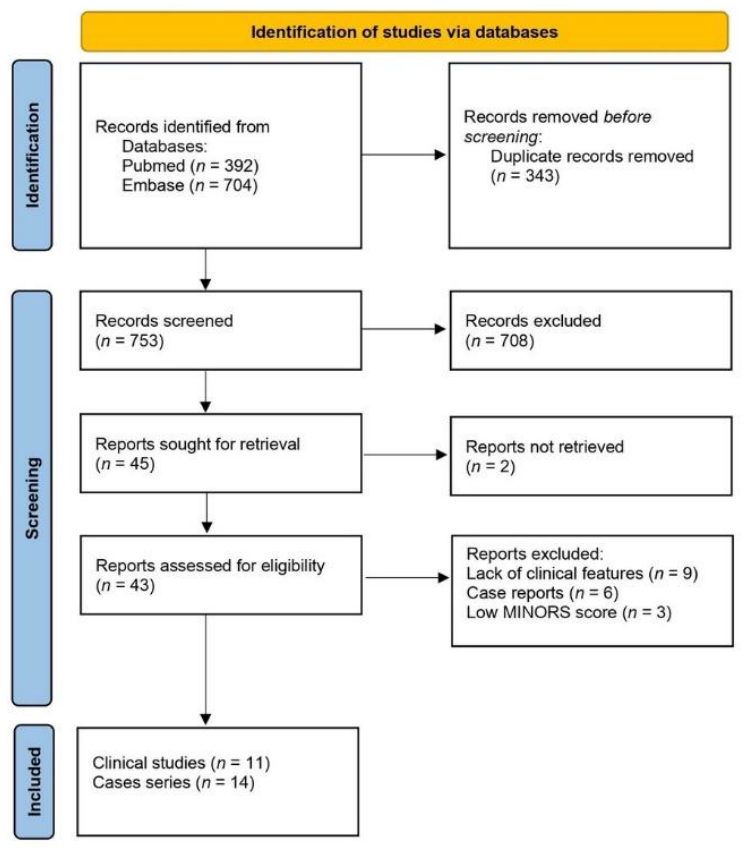
Figure 1. Flow diagram of study identification and selection. Table 1. Main characteristics of the selected studies.